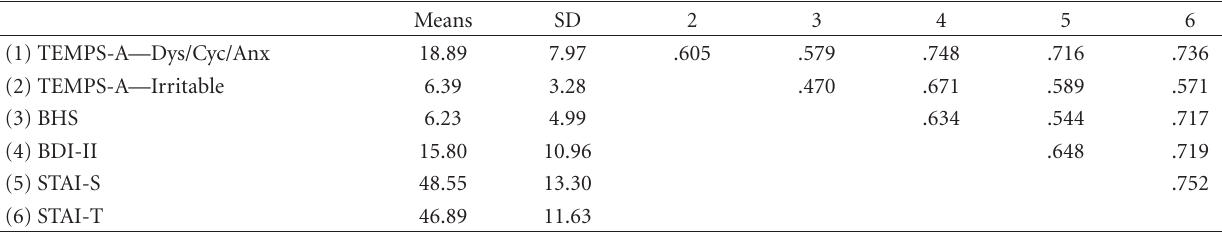
Table 2: Descriptive statistics and zero-order correlations.